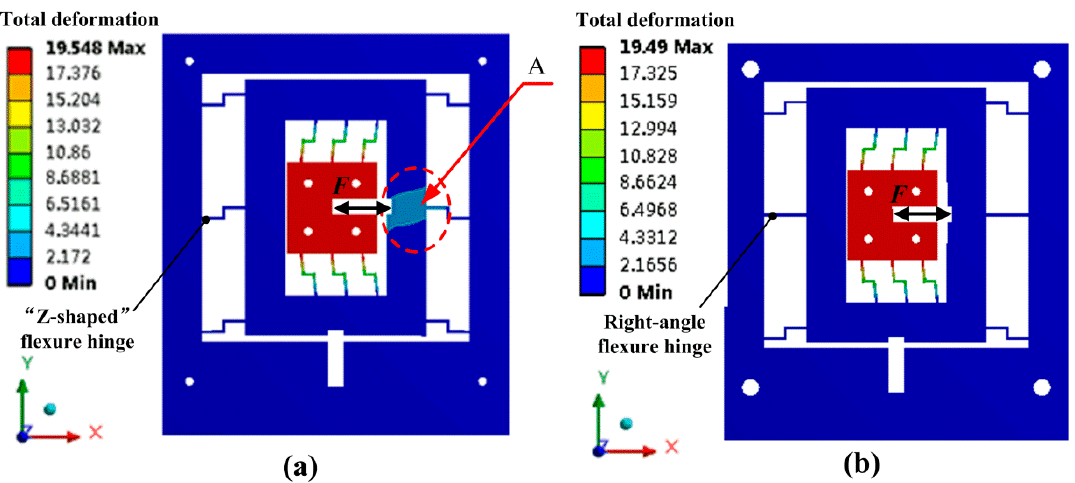
Figure 4. FEM static results of the platform: ( a ) only “Z-shaped” flexure hinges; ( b ) with right-angle flexure hinges.